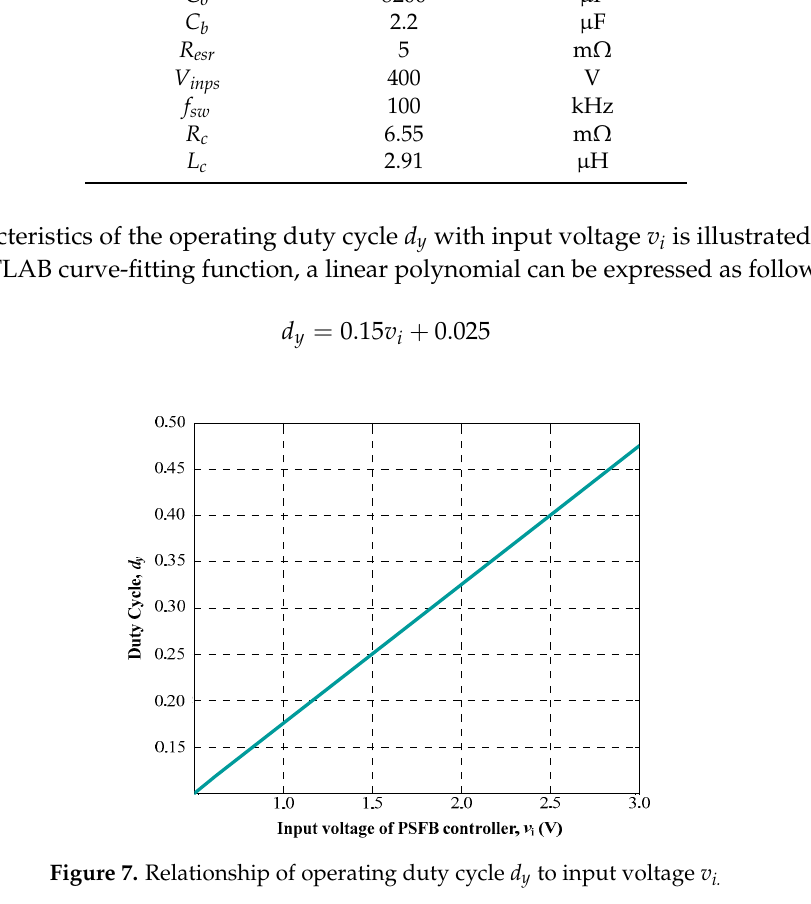
Figure 8. Bode plot simulation: G ov ( s ). 4.2. Comparison of Frequency Response Using the Different SOC Parameters and the Battery Model From Table 5, different SOC parameters resulted in different frequency responses of G ov ( s ), as illustrated in Figure 9a. Expanding the magnitude and phase scales from Figure 9a, it could be observed that three SOC (30%, 50%, and 70%) frequency responses approximated to the average